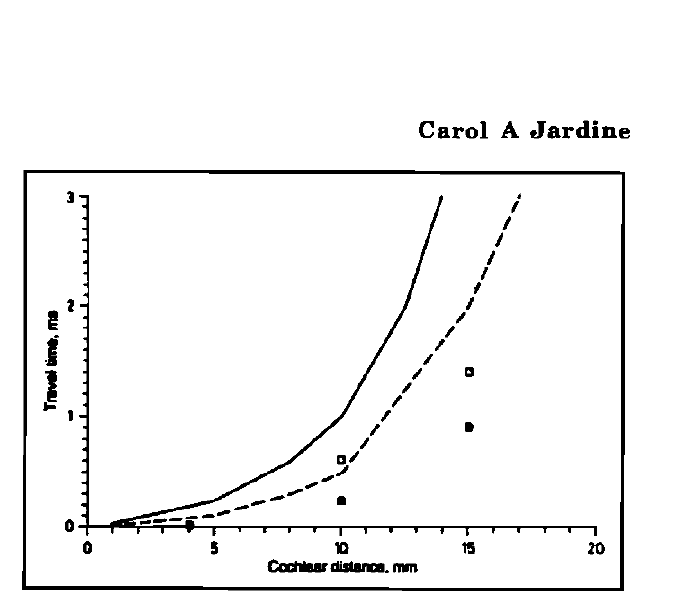
Figure 6. Time taken for a wave to traverse the length of a guinea pig cochlea. Theoretically cal- culated times ( ) are contrasted with actual